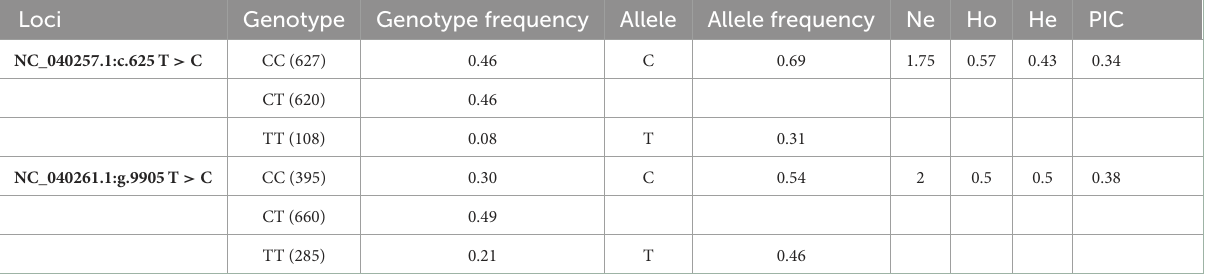
TABLE 2 The genotype frequency, allele frequency and genetic diversity of SHISA3 and RFC3 sites. Loci